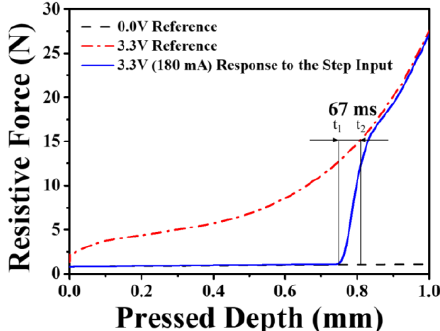
Figure 10. Measured response time of the proposed haptic stylus.